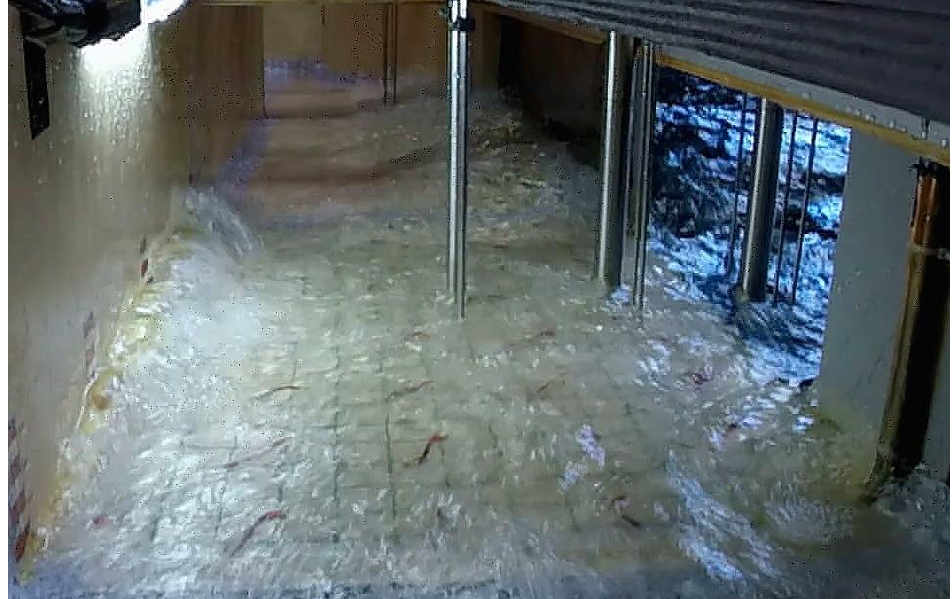
Figure 5. View on the vehicle deck of the ship model (2/3). Floodwater has reached its momentary maximum extent, and it starts to flow back towards the damage opening. The red tufts for flow visualization are still pointing towards the center casing and towards ship fore and aft directions, as a result of the floodwater that just flowed in.